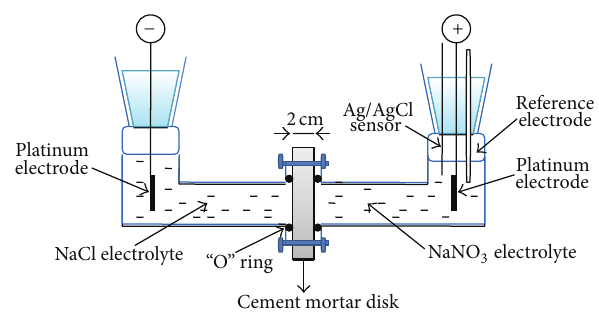
Figure 4: Experimental setup for electromigration